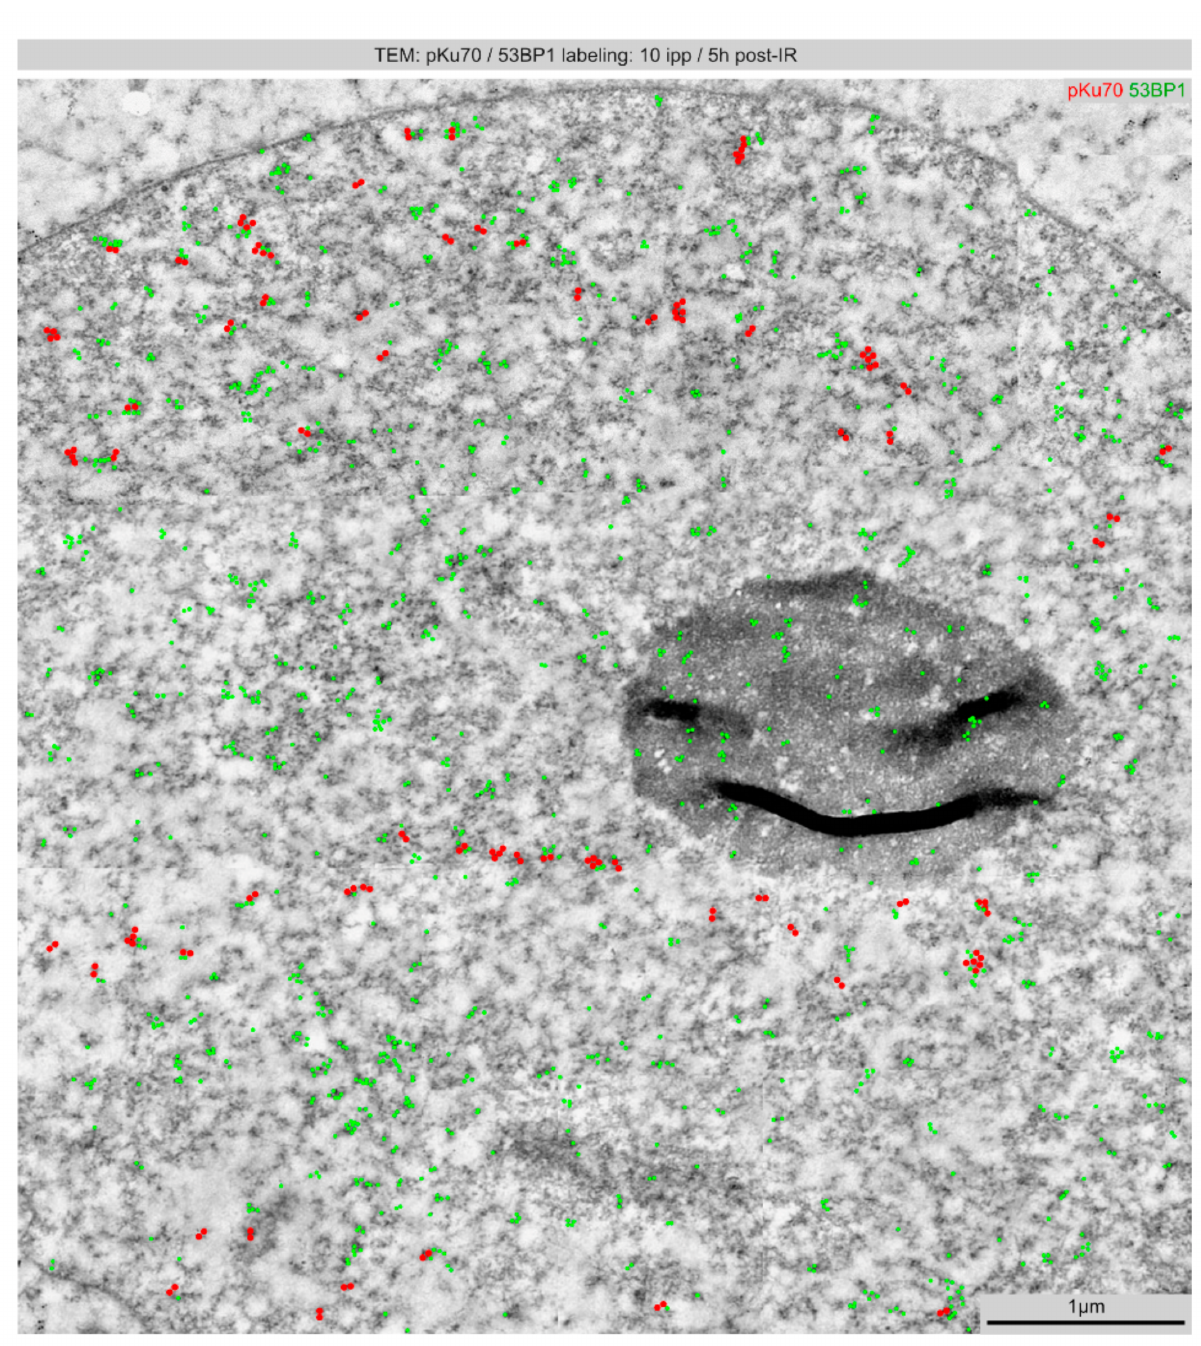
Figure 2. Spatial distribution of DNA lesions induced by multiple carbon ions (10 ipp) visualized by TEM. Micrograph of double-labeling for pKu70 (10 nm beads, colored in red) and 53BP1 (6 nm beads, colored in green) 5 h after microbeam IR with 10 ipp carbon